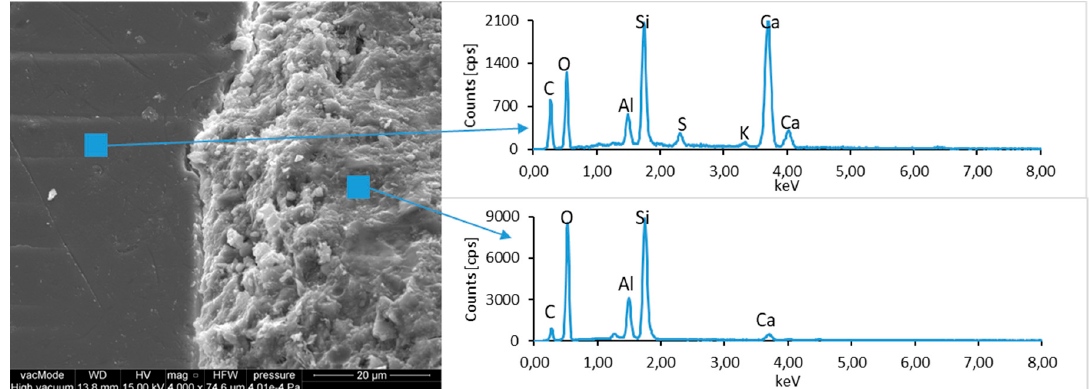
Figure 16. SEM micro-structure of CI.0 concrete and results of elemental analysis in EDS micro-area for visible portlandite grains, a fly ash particle and C–S–H phase can be seen.